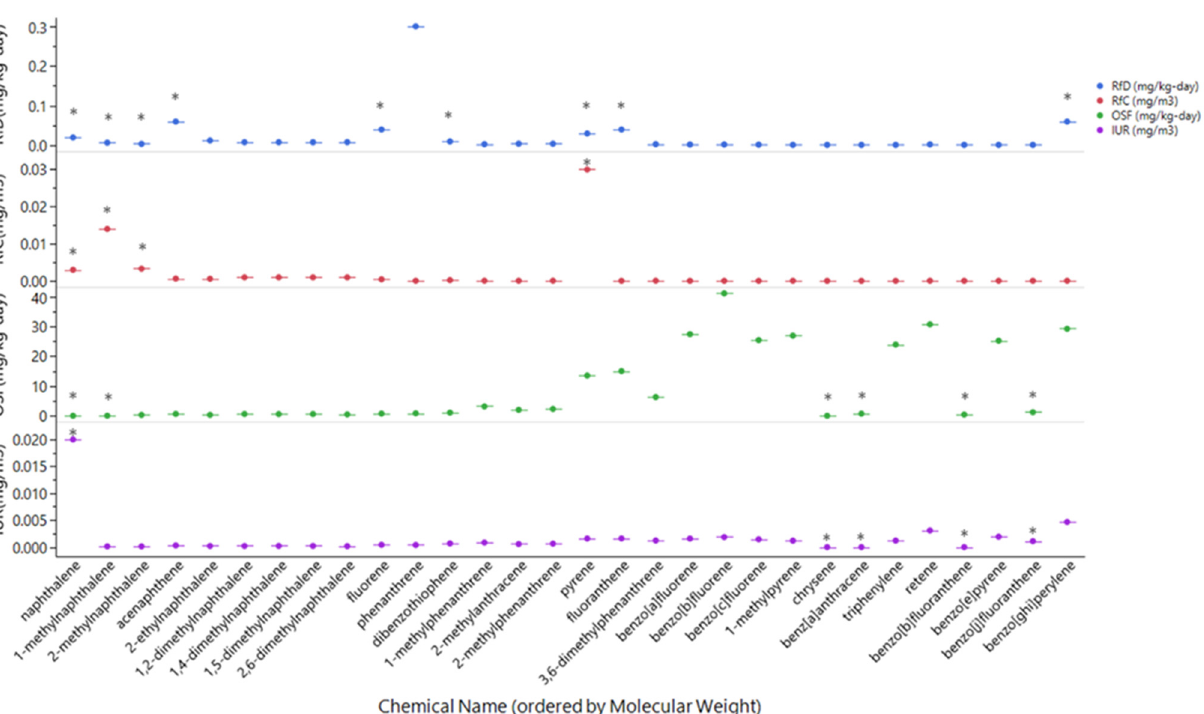
Figure 2. Comparison of Empirically Derived vs. QSAR Predicted Toxicity Values. Predicted RfD and RfC values were within the same magnitude as empirically derived values. IUR predictions were also within the same magnitude as empirical values. OSF had the largest difference between empirical and predicted values, which seemed to be associated with increasing molecular weight. *—empirically derived values. Reference Dose (RfD); Reference Concentration (RfC); Oral Slope Factor (OSF); Inhalation Unit Risk